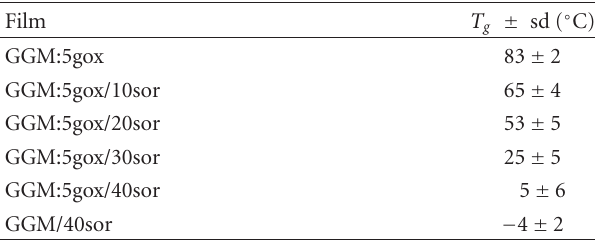
Table 2: Peak temperature of loss modulus (E (cid:4)(cid:4) ) indicating α - relaxation (glass transition, T g ) of films conditioned at 50% RH (mean ± standard deviations from three measurements).